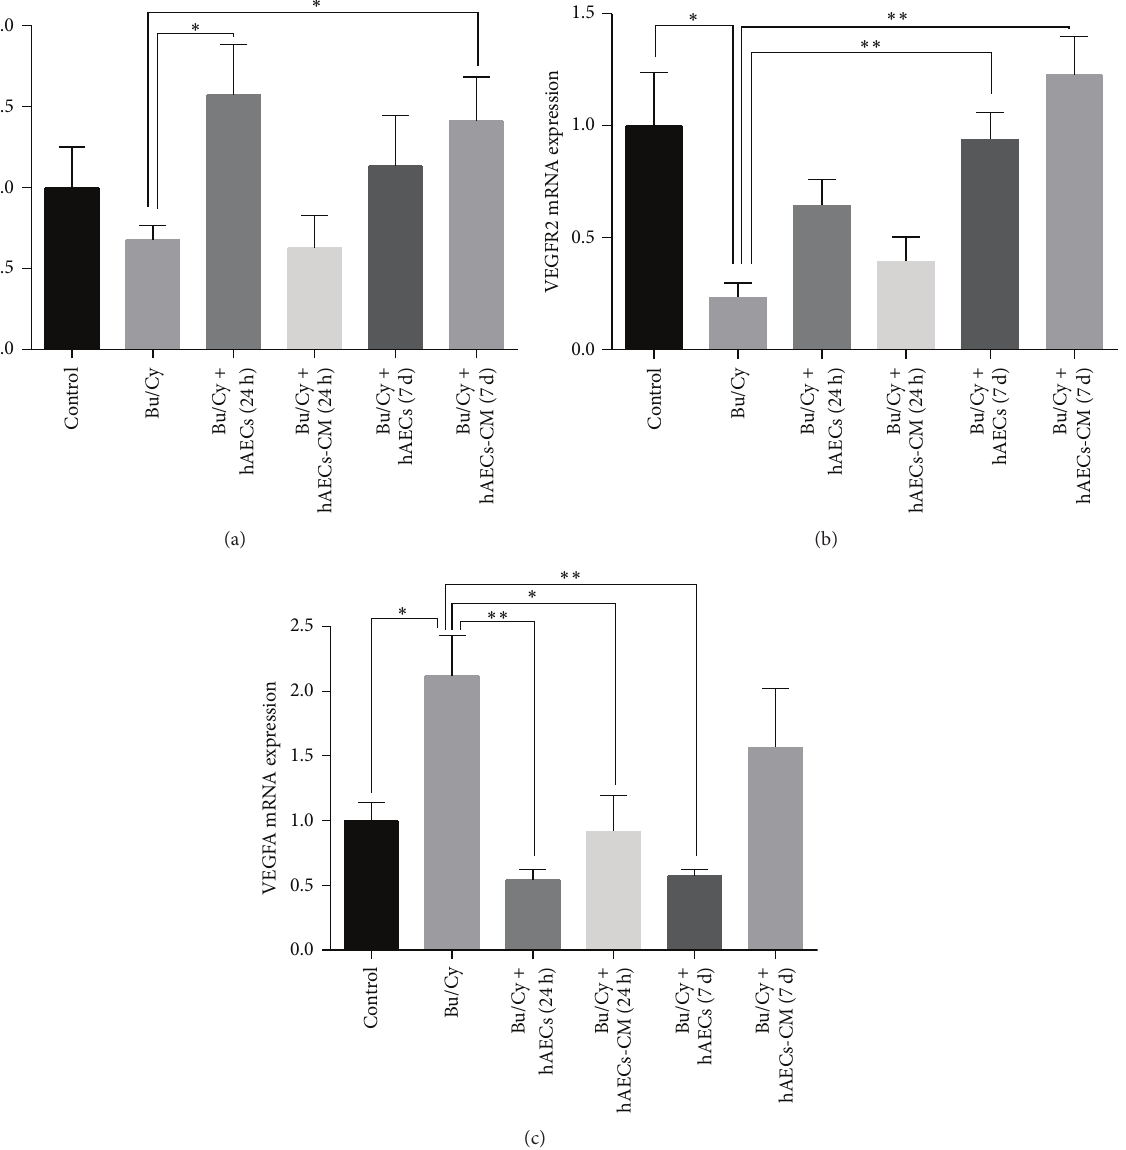
Figure 5: Real-time PCR analysis for VEGFR1, VEGFR2, and VEGFA expression in mice ovaries of different groups 2 weeks after treatment. ∗ 𝑃 < 0.05 , ∗∗ 𝑃 < 0.01 .